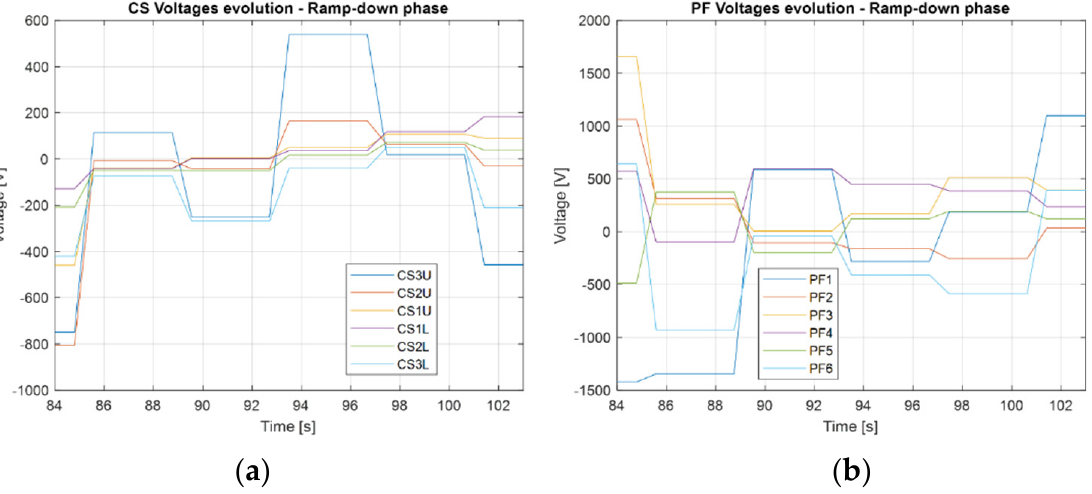
Figure 9. Time evolution of voltages for the DTT ramp-down phase: ( a ) CS voltages; ( b ) PF volt- ages. Table 7. Time evolution of CS/PF currents of the SN ramp-down phase at 250 kA/s. Time